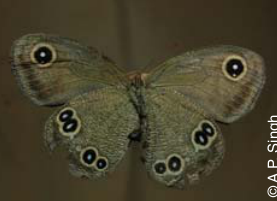
Image 134. Himalayan Yellow Flat, Celaenorrhinus dhanada (upper)